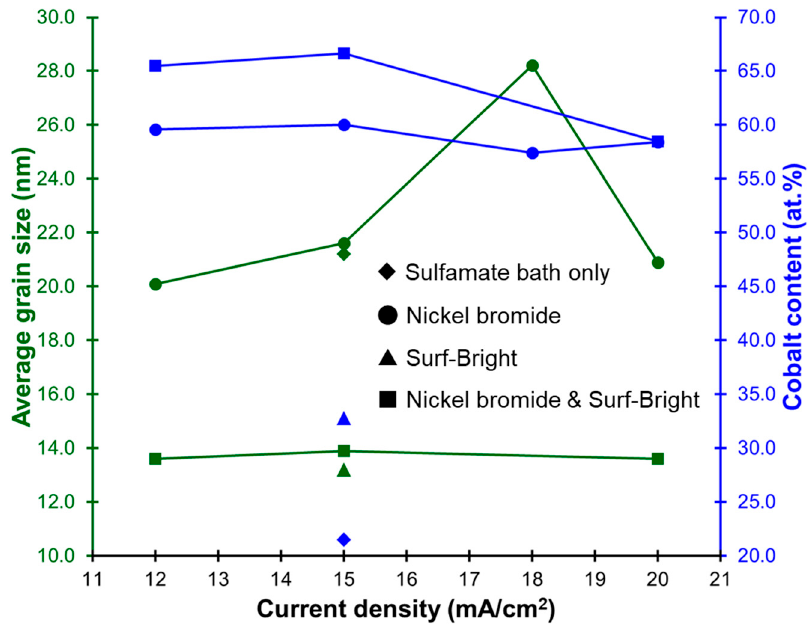
Figure 3. Relationships between the current density, average grain size and cobalt